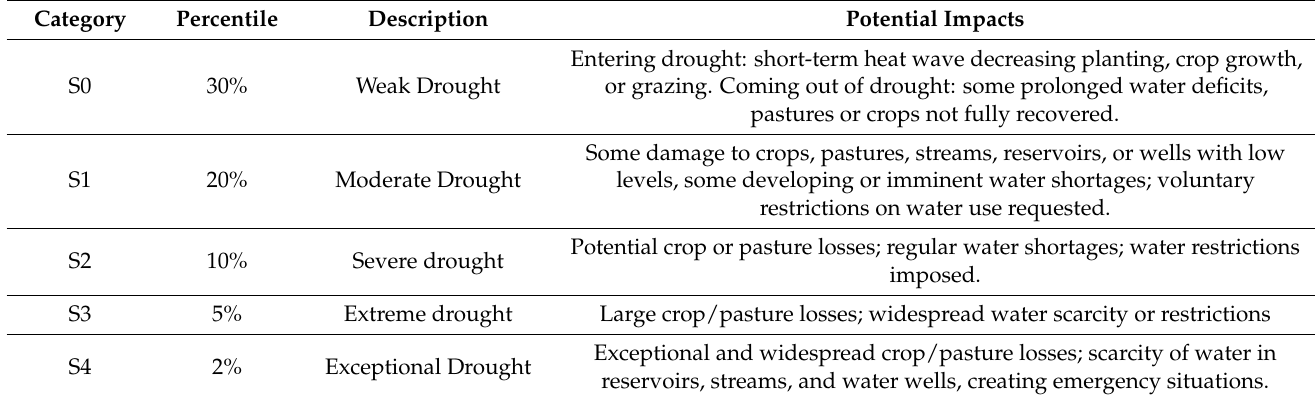
Table 2. Drought stages or categories that define the drought intensity on the Monitor map. Source: Drought Monitor, Adapted from the National Drought Mitigation Center, Lincoln, Nebraska,